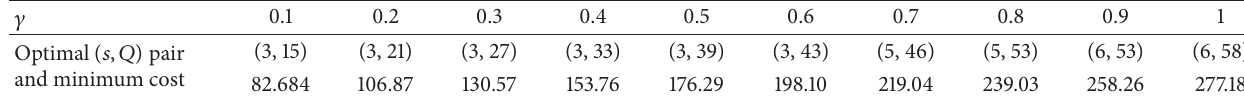
Table 1: Optimal (𝑠,𝑄) pair and minimum